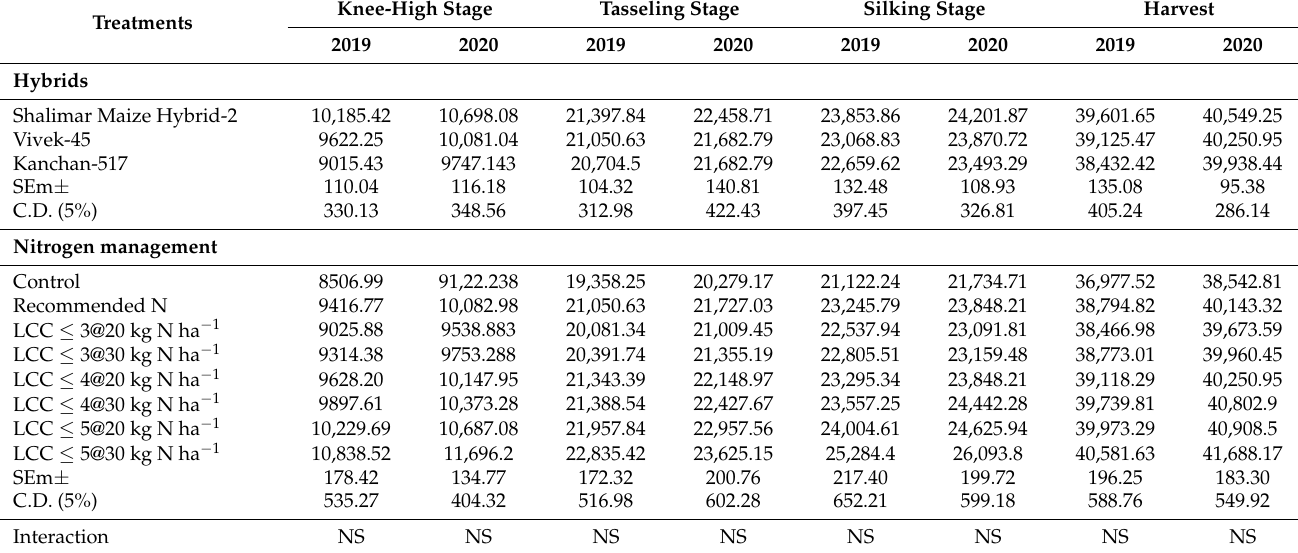
Table 6. Effect of precision nitrogen management through LCC on Photothermal ( ◦ C day hour) units of different hybrid maize